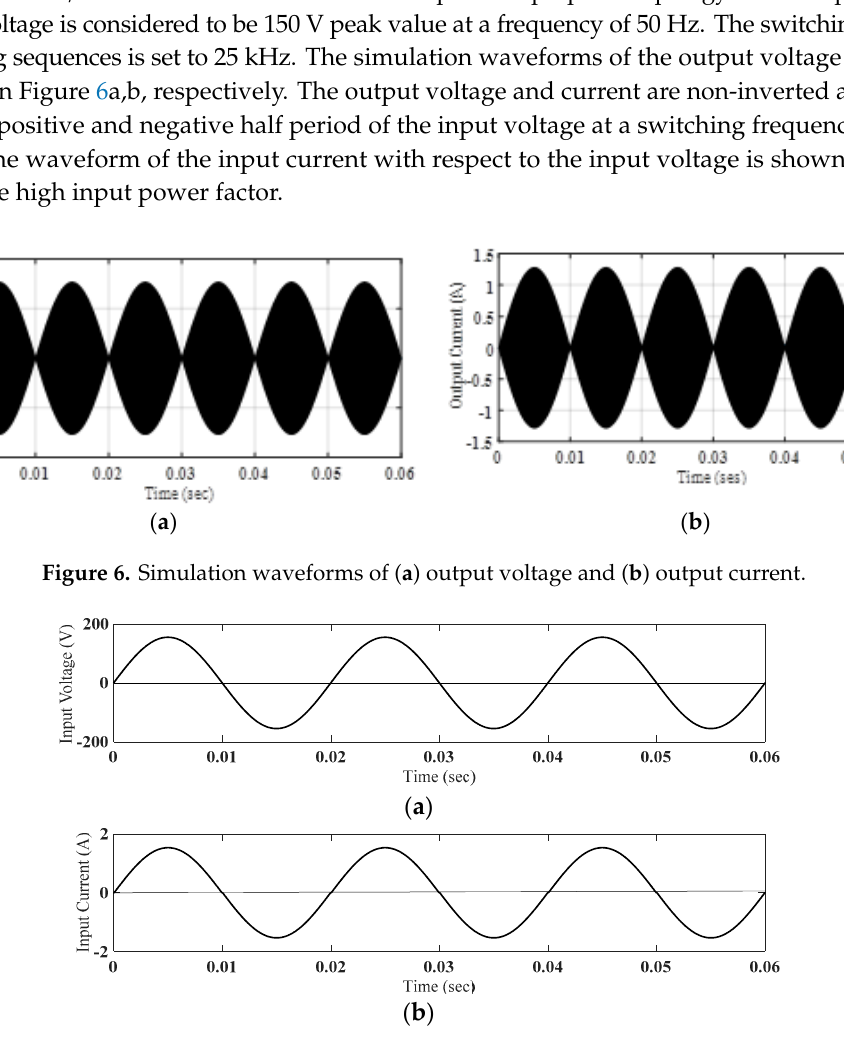
Figure 8. Power quality analysis of the input current. A practical prototype is also developed to validate the elimination of ZCD and the attained simulation results. It consists of six controlled switches (IRF840), six fast recovery diodes (RHRG3040), and one input inductor and capacitor of 1 mH and 1 µF, respectively. The six gate driving circuits are employed with hybrid chips (EXB840) with six isolated dc supplies. Figure 9 shows the hardware implementation of the proposed converter.